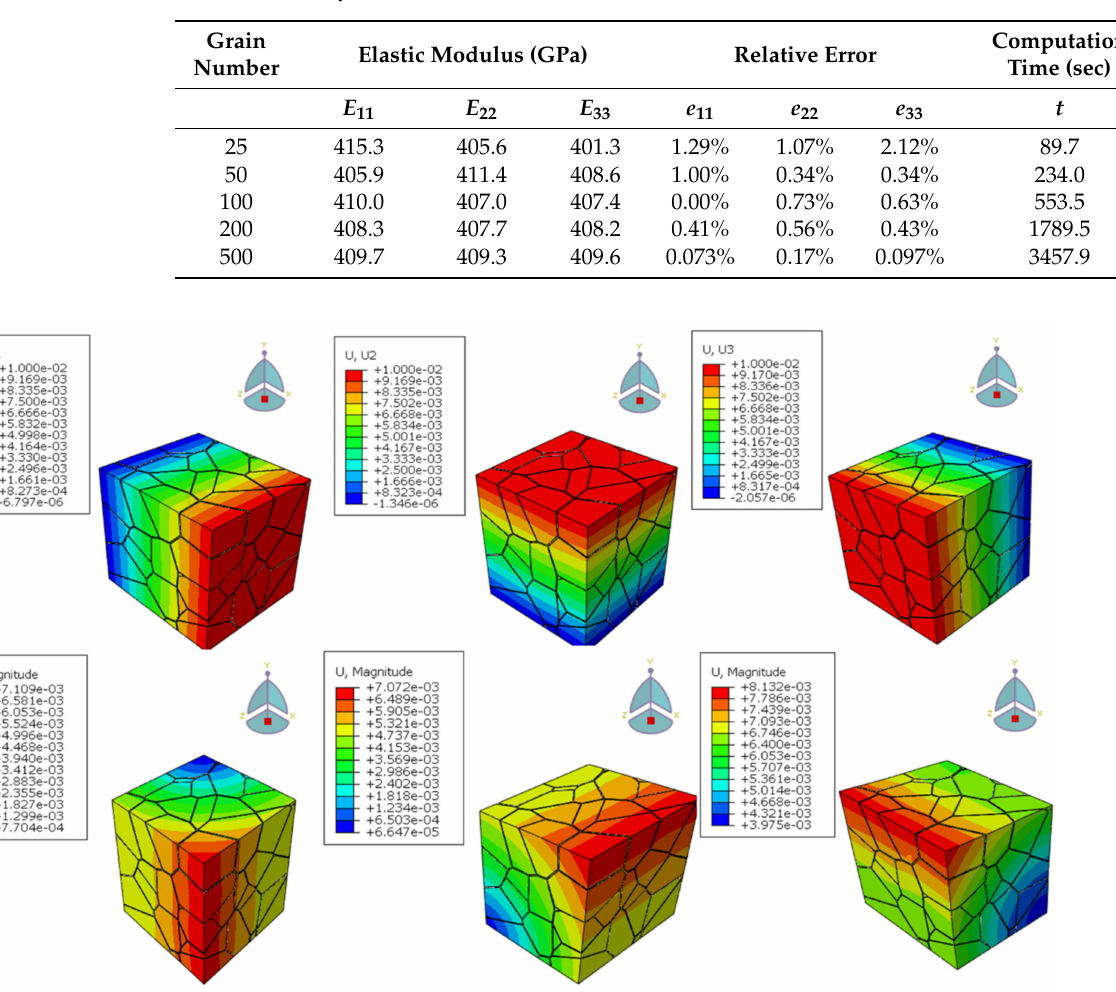
Table 2. Elasticity modulus and relative error of RVE models.